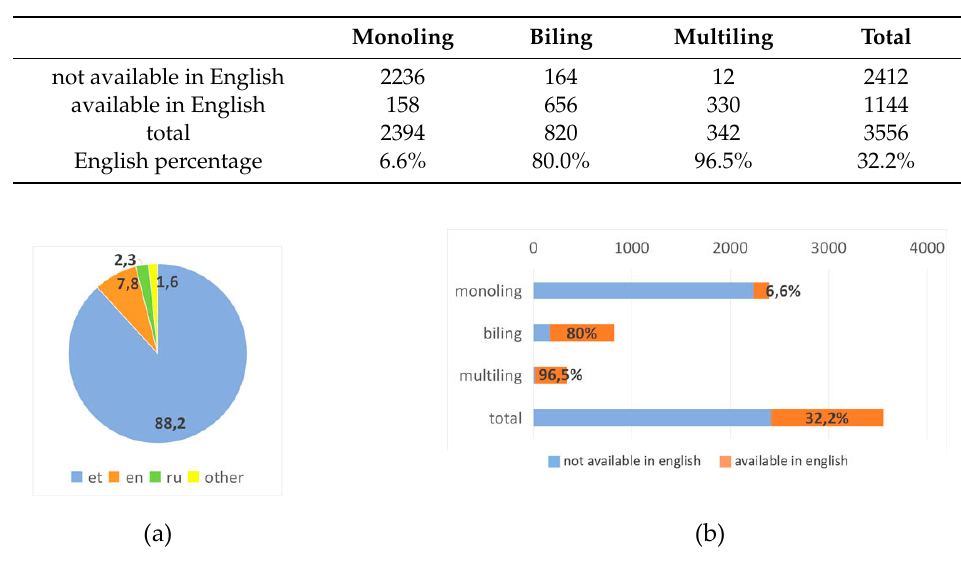
Figure A8. Visualization of the results for domain ee. ( a ) Primary languages pie chart and ( b ) English language availability bar chart.